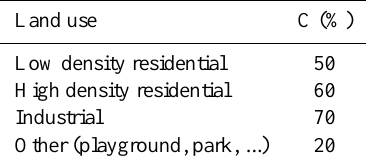
Table 3. Implementation cost of BMPs.